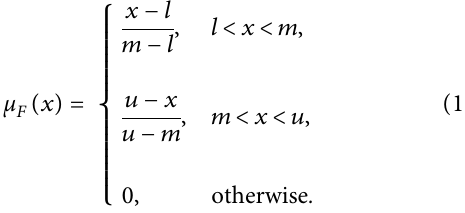
table, the target population size of Morgan table and sample